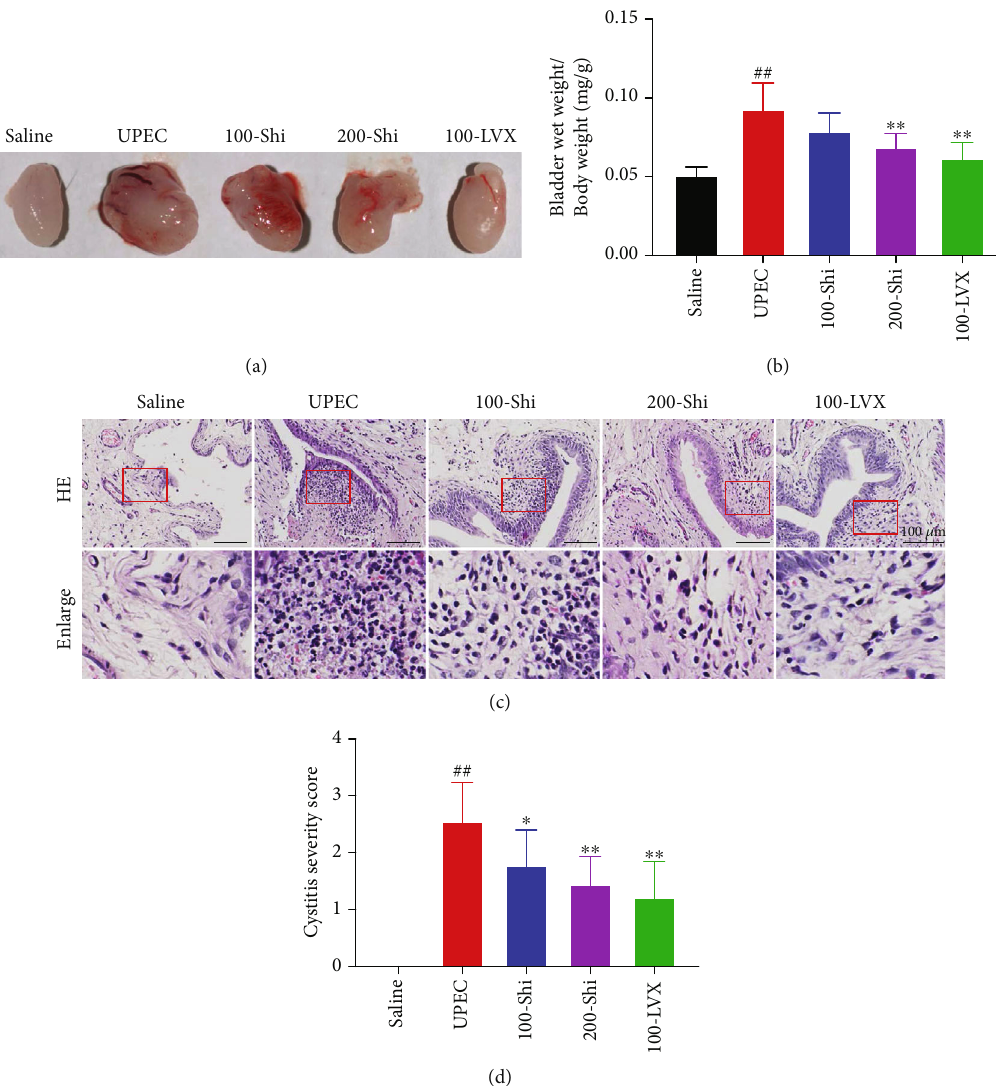
Figure 1: Shionone improves edema and congestion in the bladder of rats with acute urinary tract infection. (a) Status of the bladder in each group of rats. (b) Bladder wet weight/body weight in each group of rats. (c) Pathological analysis of HE staining of bladder tissues in each group. (d) Cystitis severity of bladder tissues in each group. Compared with the saline group, # means p < 0 : 05 and ## means p < 0 : 01 . Compared with the UPEC group, ∗ means p < 0 : 05 and ∗∗ means p < 0 : 01